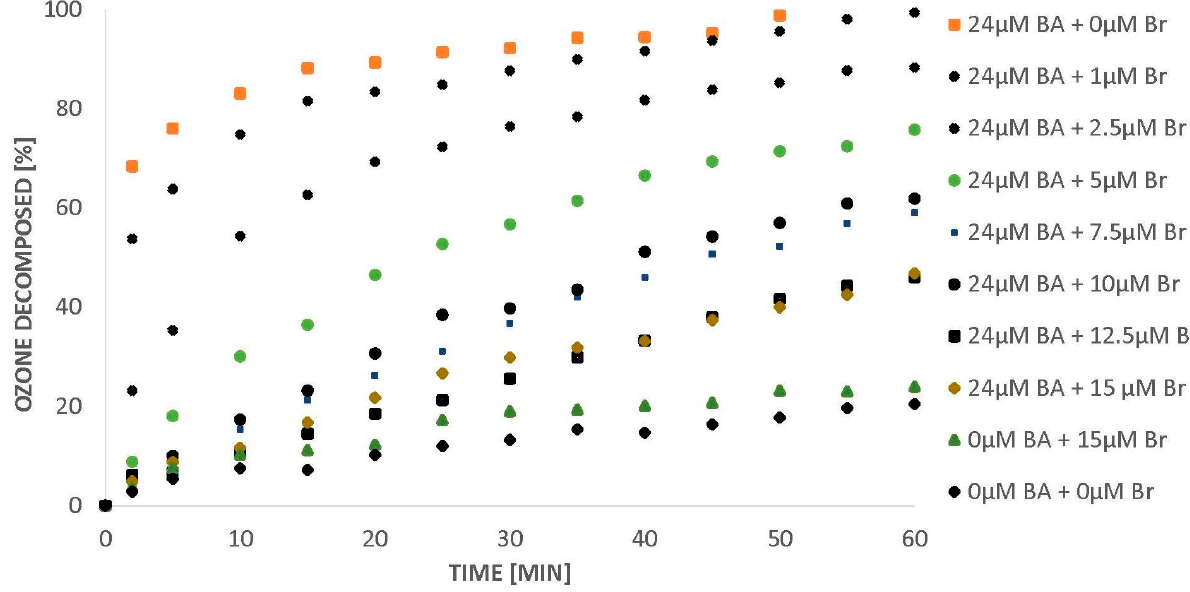
µ M) and bromides (0–15 µ M), pH